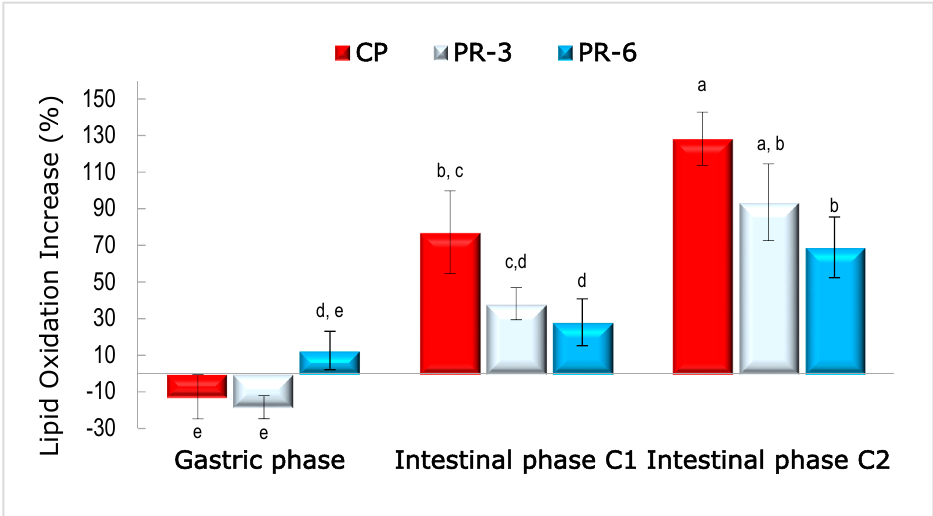
Figure 5 . Lipid oxidation increase in pork liver pâté samples after gastric and both simulated intestinal digestions. CP: control pâté; PR-3 pâté with 3% persimmon flour (Rojo Brillante); PR-6 pâté with 6% persimmon flour (Rojo Brillante). Values with different letter indicates significant differences ( p < 0.05), according to Tukey’s post host test.